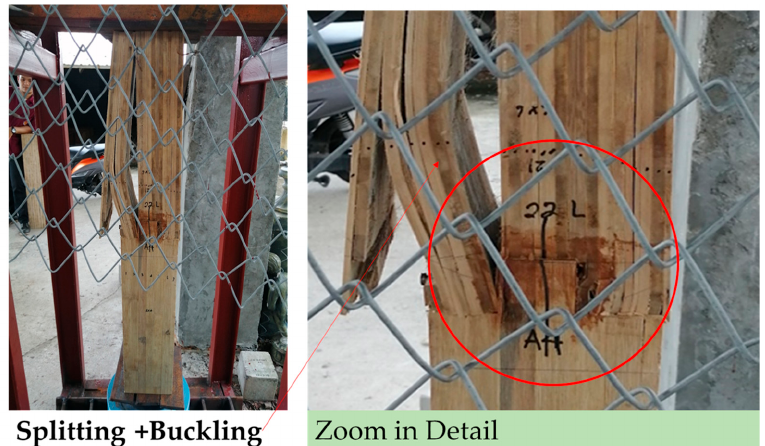
Figure 7. Splitting + buckling mode.